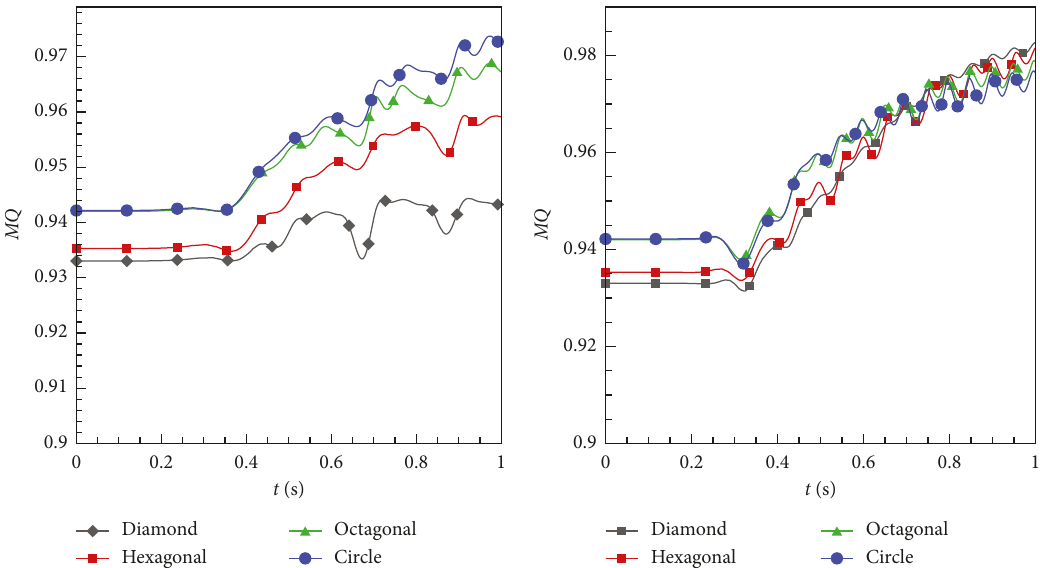
Figure 15: Variation of mixing quality in the simulation time in different mixing chambers when u � . 01 [ mm / s ] , φ � π /2 , f � 5 [ Hz ] (left) and u � . 01 [ mm / s ] , φ � π /2 , f � 10 [ Hz ]